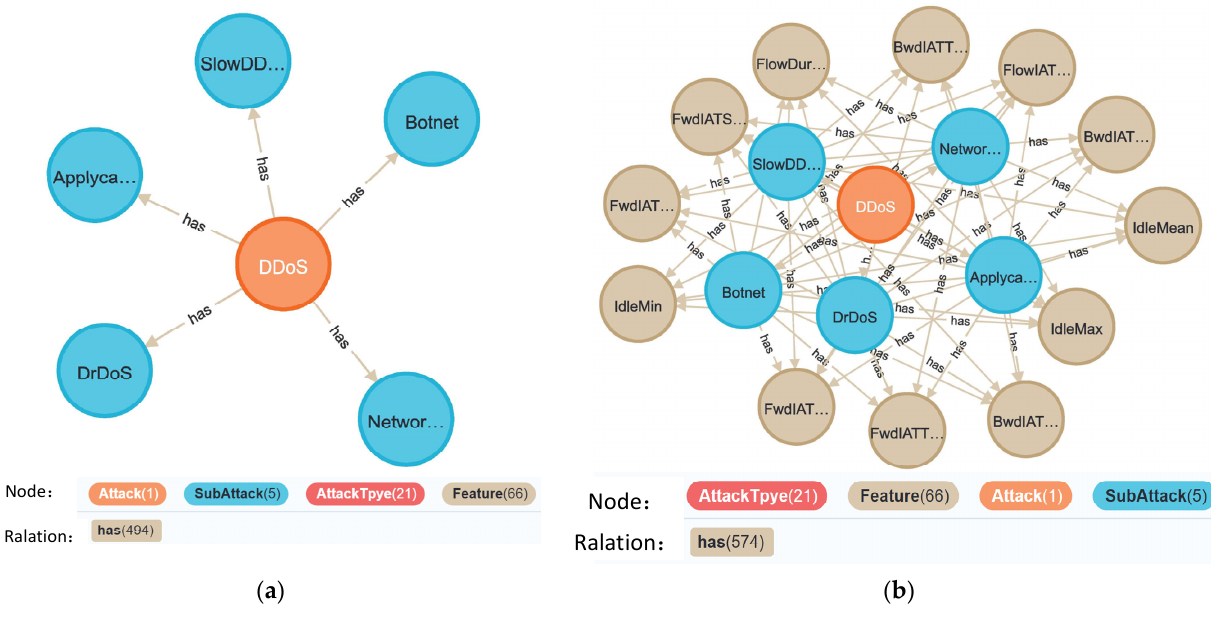
Figure 17. The update of malicious behavior feature graph: ( a ) Behavior malicious feature graph before update; ( b ) Behavior malicious feature graph after update.